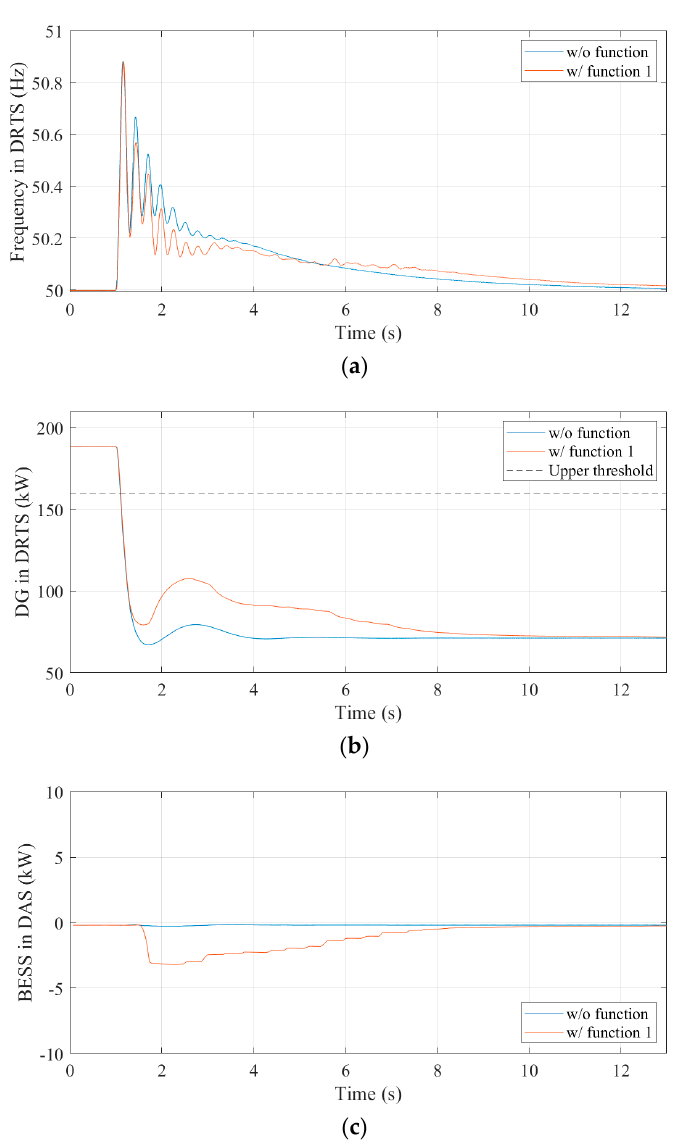
Figure 7. Function 1 test results (load reduction from 19 kW to 7 kW): ( a ) frequency; ( b ) DG set output; ( c ) BESS output. Note that 10 times scaled measurement of actual lab equipment output, i.e., BESS and load, is fed back to the DRTS in this PHIL simulation.